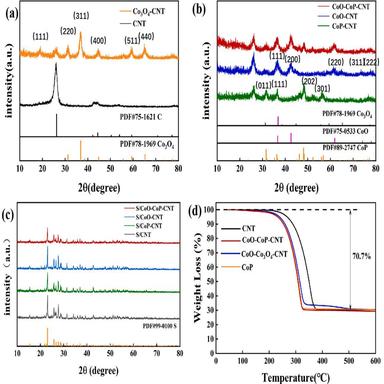
X-ray diffraction patterns (a)Co3O4-CNT and CNT, (b) CoO-CoP-CNT, CoO-CNT and CoP-CNT and (c) S/CoO-CoP-CNT, S/CoO-CNT, S/CoP-CNT and S/CNT. (d) TGA curves of S/CoO-CoP-CNT, S/CoO-CNT, S/CoP-CNT and S/CNT.